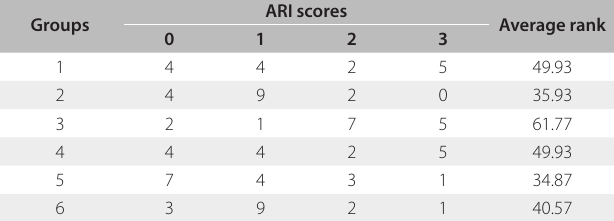
Table 2. Adhesive Remnant Index (ARI) scores and average rank for each group